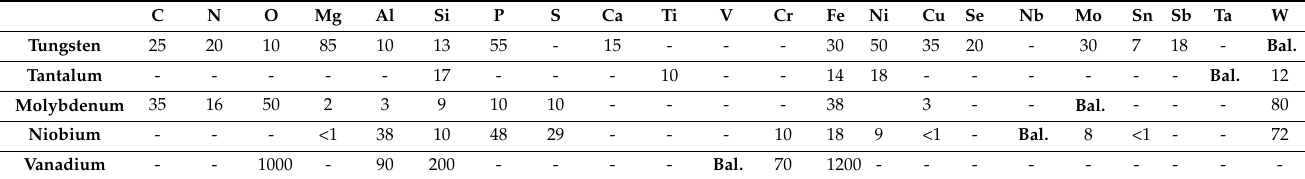
Table 2. Chemical composition of the pure elemental powders in terms of impurities [ppm].